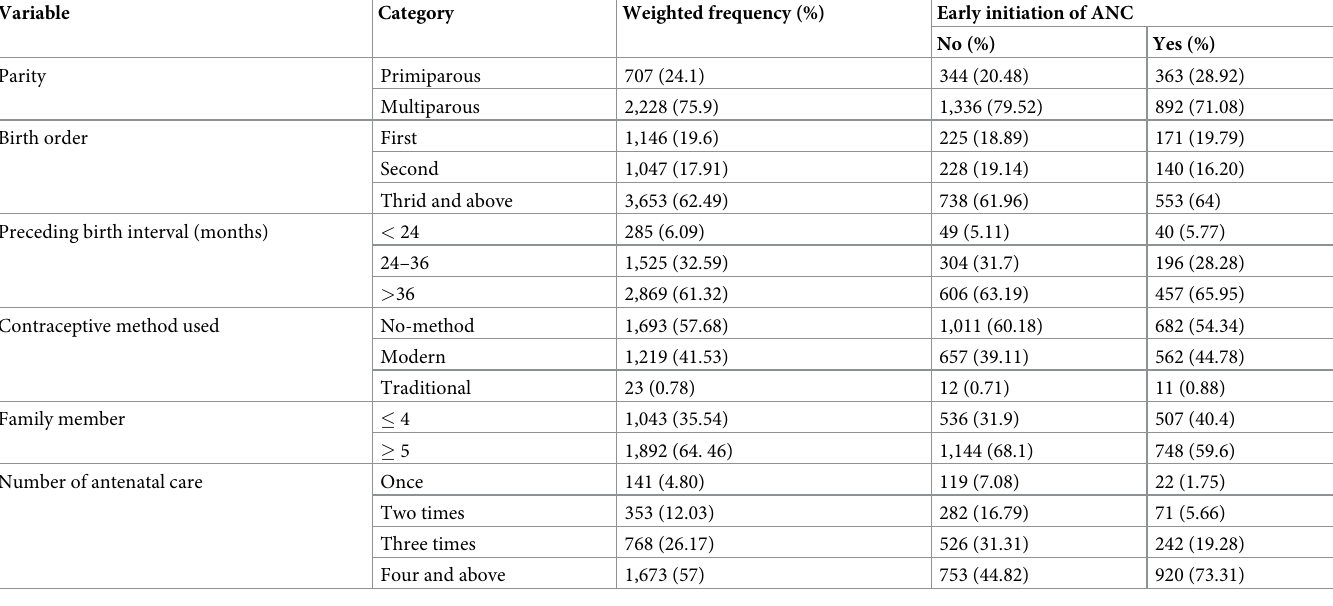
Table 3. Early initiation of antenatal care by different obstetric and reproductive health-related characteristics of reproductive-age women in Ethiopia, 2019.